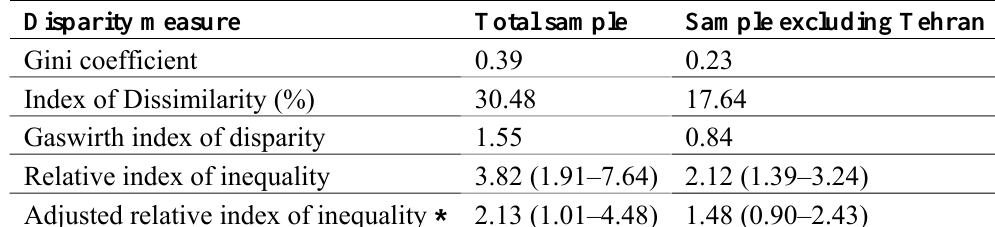
Table 1. Pure and between area-socioeconomic disparity measures in the distribution of dentists in Iran, 2009.